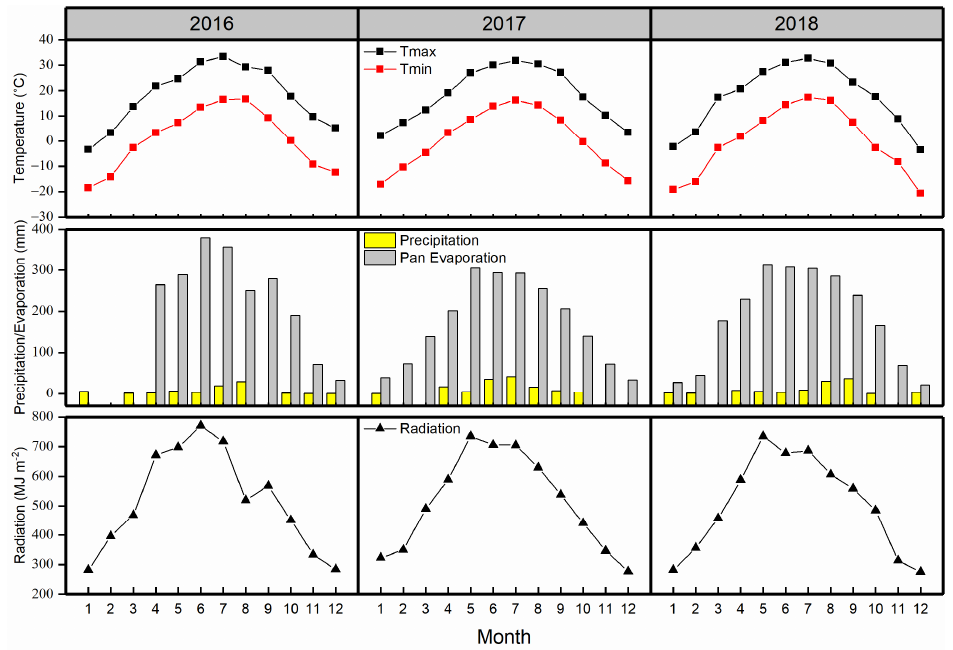
Figure 1. Monthly maximum (Tmax), and minimum (Tmin) average air temperature (°C), precipitation (mm), pan evaporation (mm), and cumulative radiation (MJ m −2 ) at the experimental station in 2016–2018.